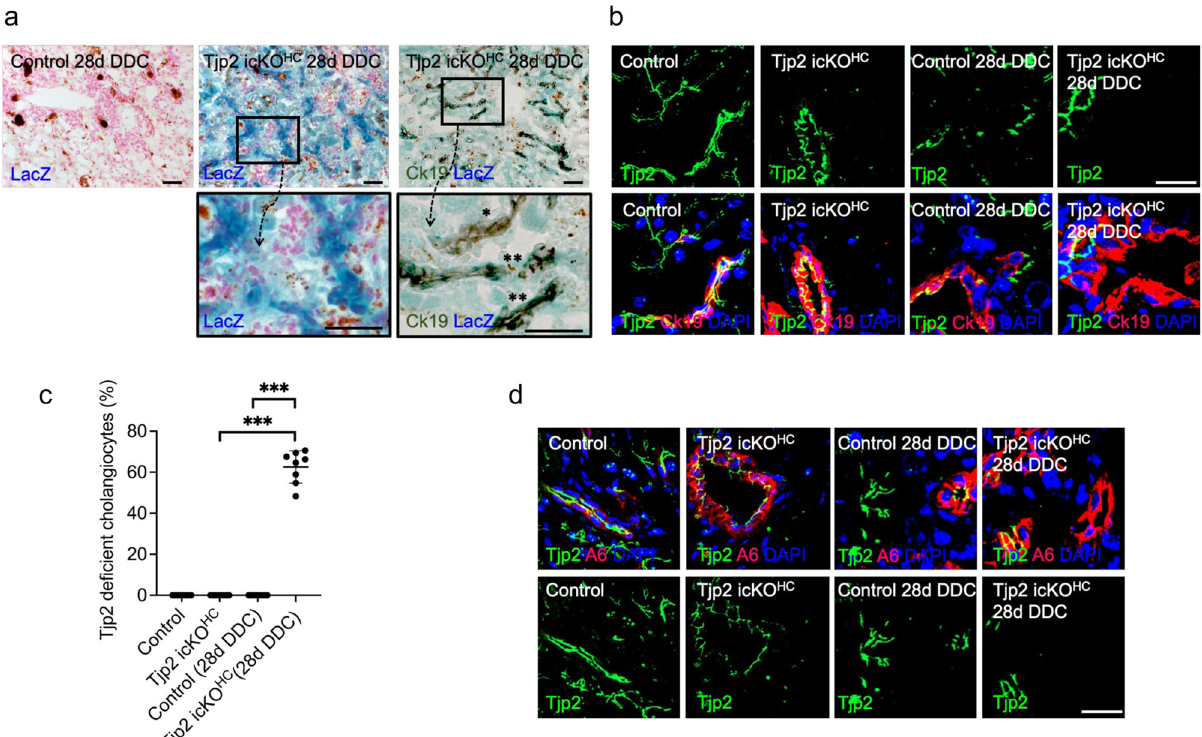
Fig. 4 Tjp2 de fi cient hepatocytes give rise to the DDC-diet-induced ductular cells. a Lineage tracing. One week after the last tamoxifen dose to induce deletion of the indicated genes, mice were fed a DDC diet for 28 days and sacri fi ced. LacZ and Ck19 staining of control and Tjp2 icKO HC Rosa26:LacZ mouse liver samples, showing Ck19-positive ductular structures derived from LacZ-positive hepatocytes ( ✽✽ ) and resident LacZ-negative Ck19-positive bile ducts ( ✽ ). Scale bar: 50 μ m. b , c Tjp2 and Ck19 staining of control and Tjp2 icKO HC liver sections from mice fed standard or DDC diet and quanti fi cation. Scale bar: 20 μ m. d Tjp2 and A6 staining of control and Tjp2 icKO HC liver sections from mice fed standard or DDC-diet. Note that in Tjp2 icKO HC animals, Tjp2 is deleted in hepatocytes, thus showing that Tjp2-negative and Ck19- or A6- positive ductular cells arise from Tjp2 -de fi cient hepatocytes. icKO HH , tamoxifen-induced hepatocyte deletion. Scale bar: 20 μ